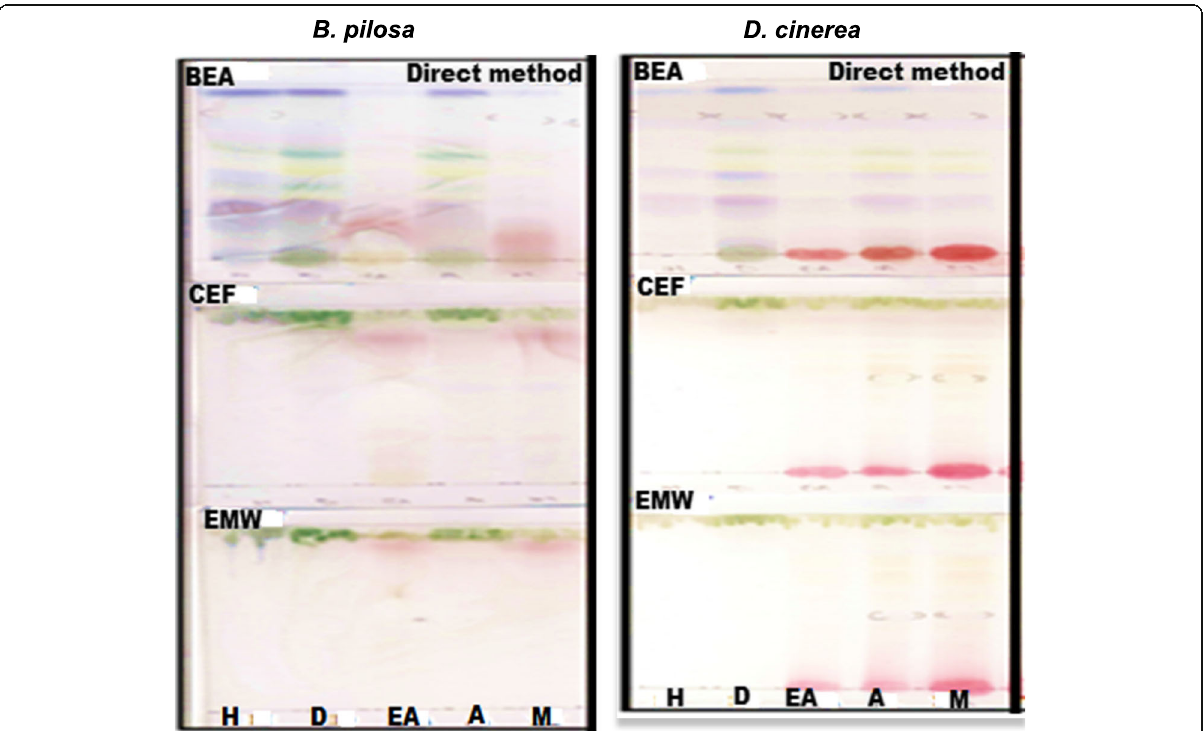
Fig. 2 TLC fingerprint profile of plants extracted using the direct extraction method eluted in three solvent systems of varying polarities that show reactive compounds detected by vanillin sulphuric-acid reagent. BEA, Benzene: ethanol: ammonia hydroxide; CEF, Chloroform: ethyl acetate: formic acid; EMW, Ethyl acetate: methanol: water; H, hexane; D, dichloromethane; EA, ethyl acetate; A, acetone; M,